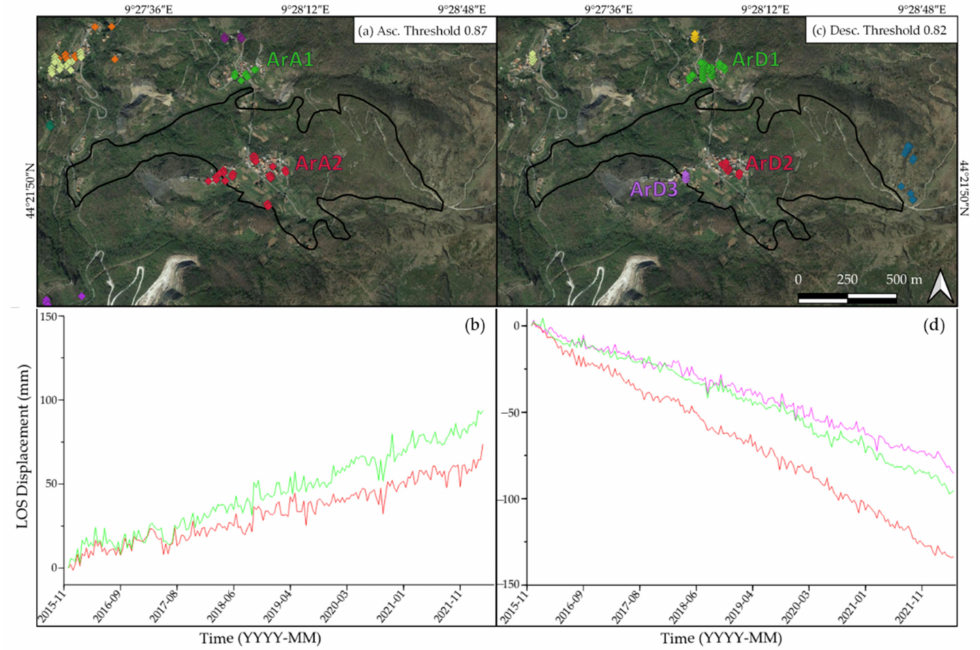
Figure 11. In ( a,c ) the chosen thresholds for ascending and descending orbits, respectively, are reported for the Arzeno test site. In ( b , d ) the time-series of a reference PS for each family identified with CAPS in both orbits are